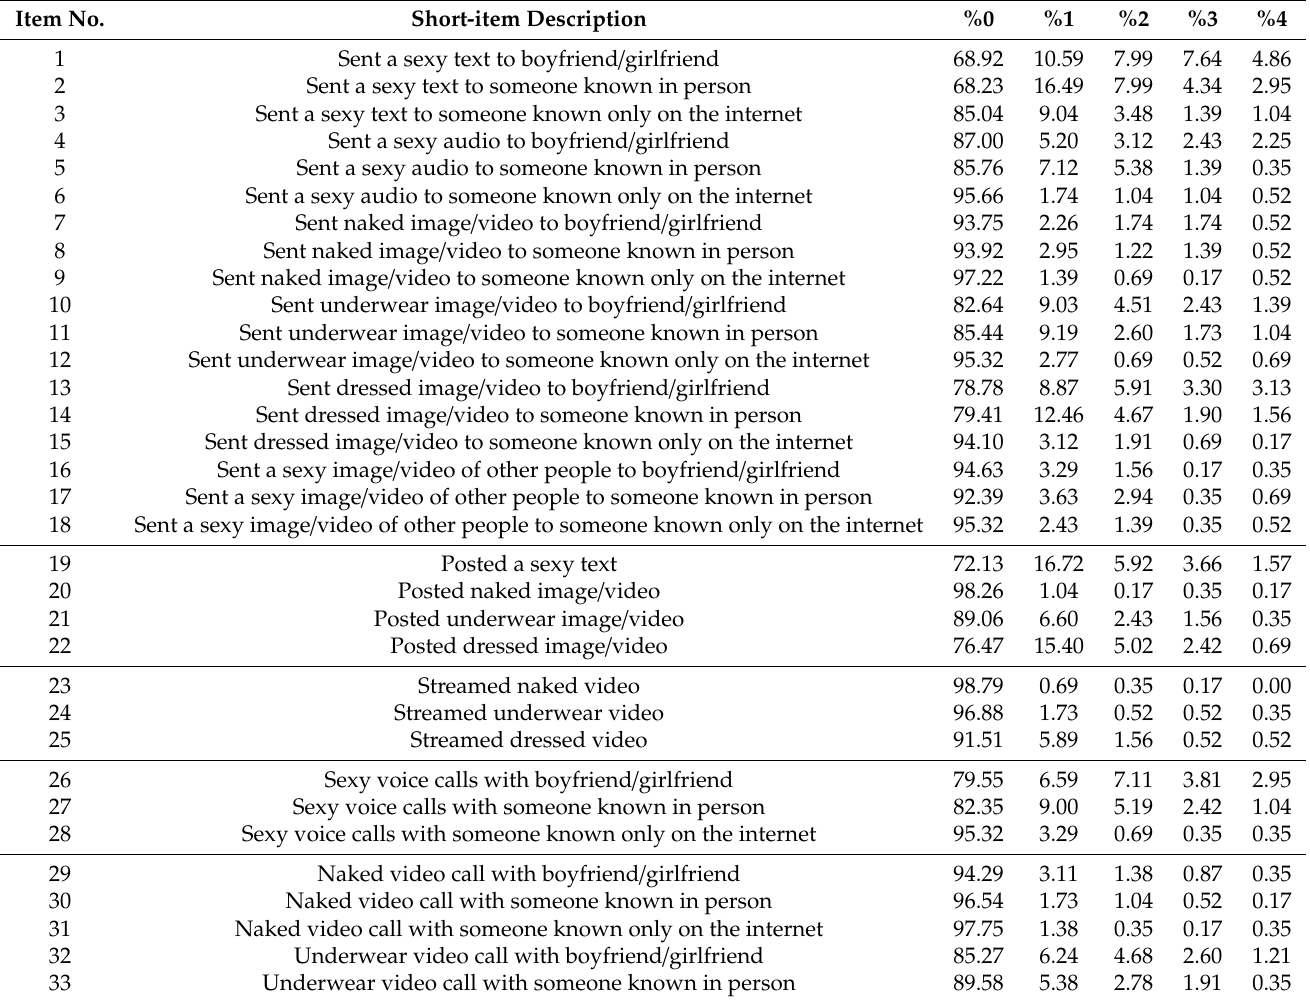
Table 2. Proportion of category frequency responses of Adolescent Sexting Scale (A-SextS)